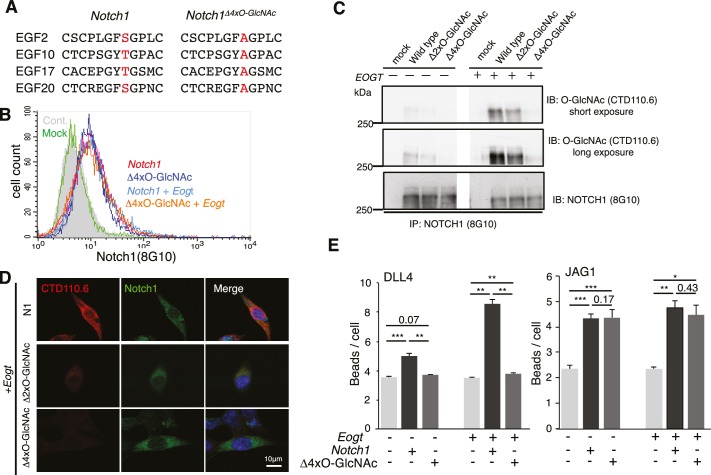
O-GlcNAc on NOTCH1 EGF repeats promotes DLL4-NOTCH1 interactions.(A) Ala substitution of Thr/Ser in the O-GlcNAc consensus site C5XXG(Y/F)(T/S)GXXC6 in EGF2, 10, 17, and 20 in the NOTCH1Δ4xO-GlcNAc mutant. (B) Cell surface expression of NOTCH1Δ4xO-GlcNAc is comparable to that of wild-type NOTCH1. EOGT-null transfectants expressing Notch1 or Notch1Δ4xO-GlcNAc with or without Eogt were subjected to flow cytometry using 8G10 NOTCH1 antibody. Control transfectants were with (Mock) or without (Cont) primary antibody. Similar results were obtained for wild-type HEK293T cells (not shown). (C) Expression and O-GlcNAcylation of Notch1, Notch1Δ2xO-GlcNAc and Notch1Δ4xO-GlcNAc were analyzed by immunoprecipitation (IP) using NOTCH1 (8G10) antibody, followed by immunoblotting with CTD110.6 O-GlcNAc or NOTCH1 antibodies. (D) HEK293T transfectants expressing NOTCH1, NOTCH1Δ2xO-GlcNAc or NOTCH1Δ4xO-GlcNAc were immunostained for O-GlcNAc (CTD110.6 mAb; red) or NOTCH1 (8G10 mAb; green). Merged images include DAPI (blue) staining. Note that CTD110.6 mAb binding is markedly decreased in the NOTCH1Δ4xO-GlcNAc mutant. (E) Quantification of the number of DLL4- or JAG1-coated Dynabeads bound to Notch1 versus Notch1Δ4xO-GlcNAc transfected cells (marked with GFP), in the presence and absence of Eogt. Data are mean ± S.D from three independent experiments. Each experiment analyzed 50 cells. *p<0.05; **p<0.01; ***p<0.001 (Welch's t test).DOI:
http://dx.doi.org/10.7554/eLife.24419.00610.7554/eLife.24419.007Figure 2—source data 1.Raw data for Figure 2E.